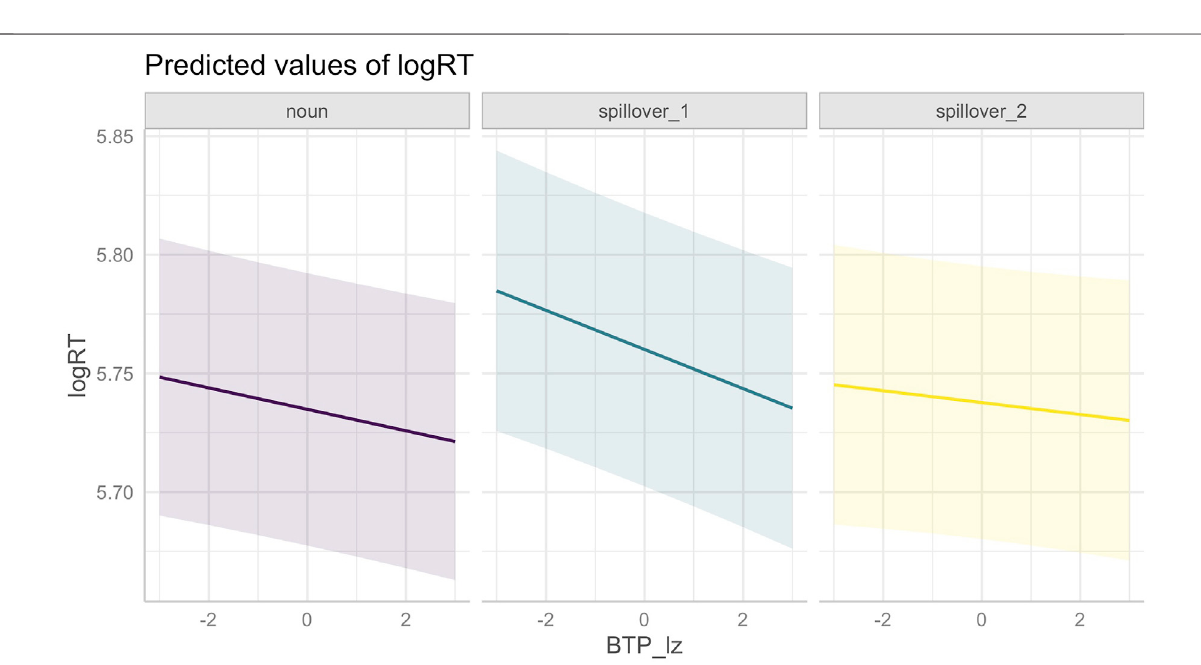
Frontiers in Communication |